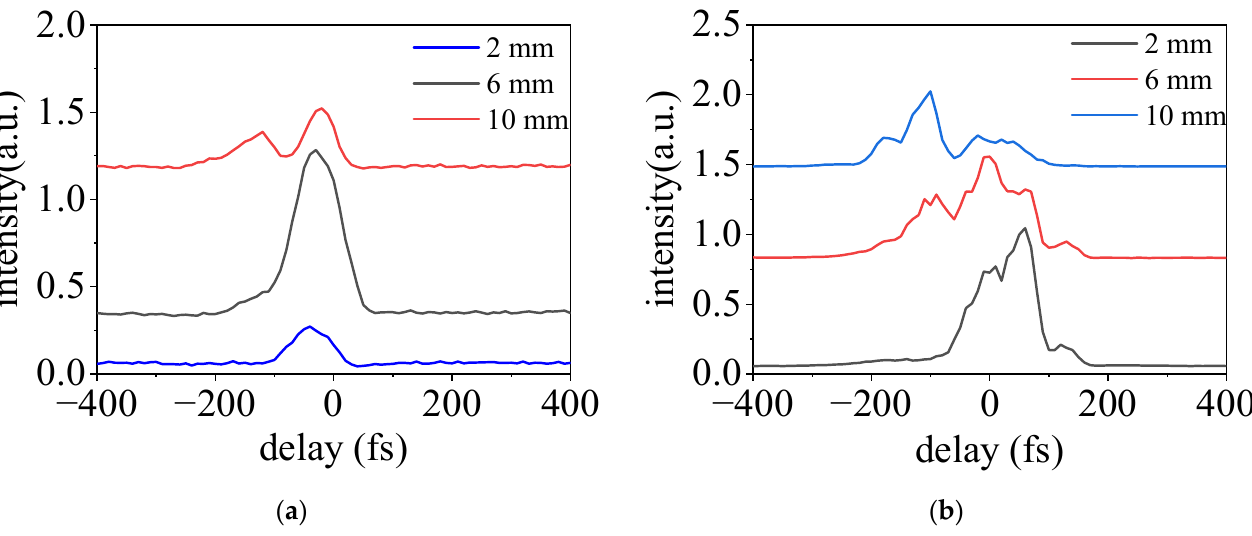
Figure 4. The temporal evolution of the SH signal generated in the nitrogen gas at the pressure of 15 mbar ( a ) and 80 mbar ( b ); 2 mm, 6 mm, and 10 mm correspond to the front, middle, and rear sections of the plasma, respectively.